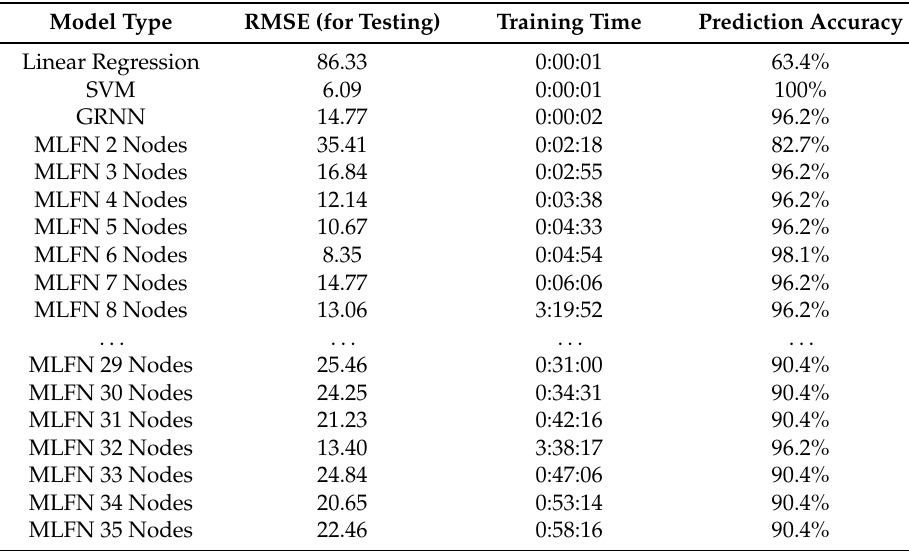
Table 2. Prediction models using experimental data by Ihmels et al. [24].